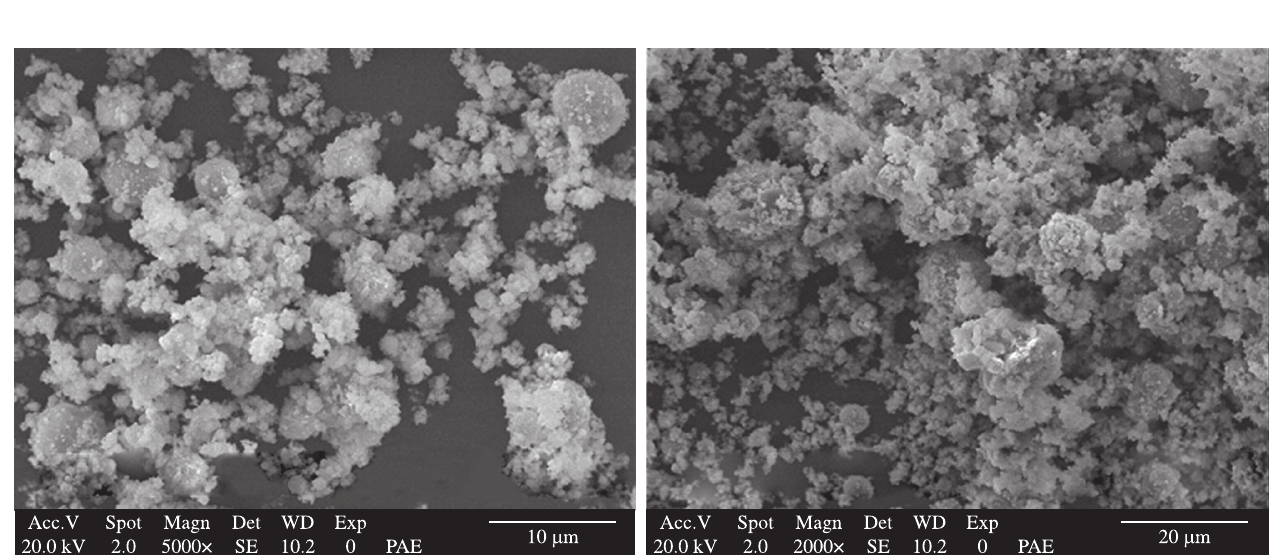
Figure 3. Secondary electrons SEM image of the